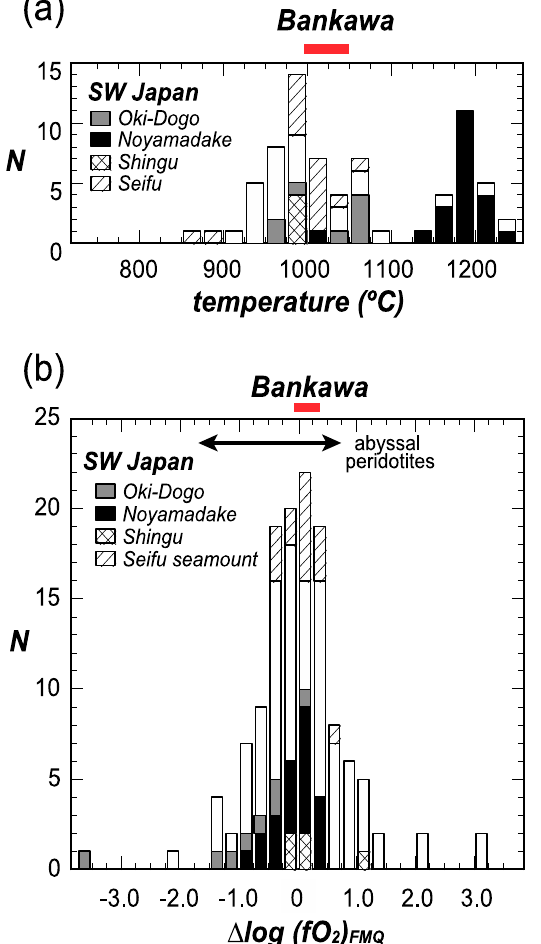
Figure 12. Ranges of equilibrium temperature and oxygen fugacity of the Bankawa lherzolite in comparison with peridotite xenoliths from the SW Japan arc. Histograms are from Arai and Ishimaru [4,6]. Temperatures were calculated after Wells [48]. ∆ log( f O 2 ) FWQ is calculated oxygen fugacity relative to the fayalite–magnetite–quartz buffer assuming a pressure of 1.5 GPa [90].